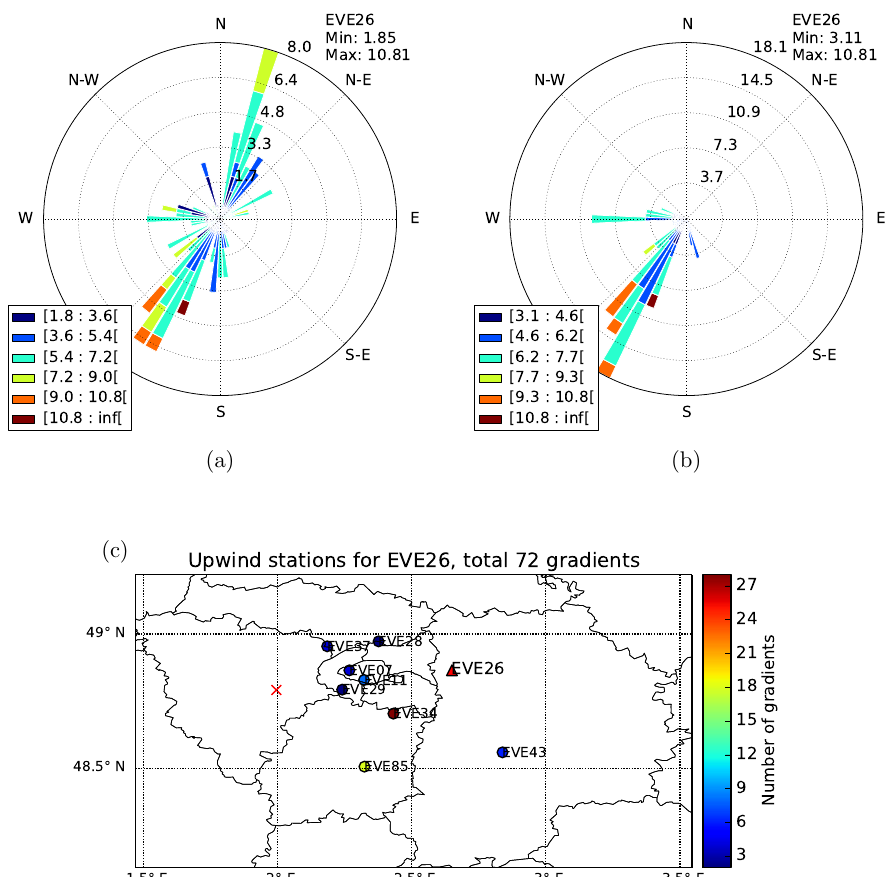
Figure 6. Results of selections of upwind stations for gradient computations for EVE26 (see Fig. 4; R-type network of 10 stations) for the month of January 2011: (a) the afternoon wind conditions at EVE26 during the given month; (b) the afternoon wind conditions for the observations selected for gradient calculation at EVE26; (c) the number of times a site is selected as upwind for gradient computations at EVE26. The leftmost red cross indicates a site that is never selected for gradient computation for